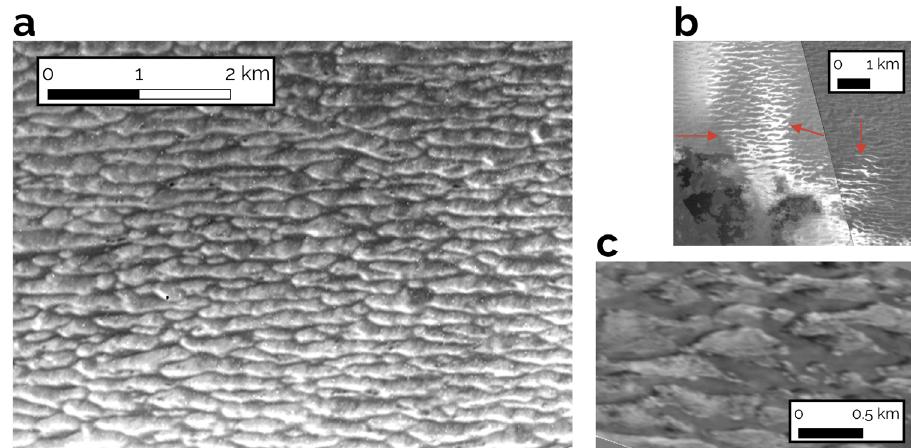
Fig. 3 Ridges of possible aeolian origin from the Galileo Solid State Imager. a Adjacent to Prometheus Patera, within kilometers of the lava fl ow fi eld. b Potential evidence of vapor fl ow indicated by the arrows at the margin of the same ridge fi eld shown in a . c Ridges near Chaac Patera. Geographic coordinates and image IDs are tabulated in Supplementary Table 2.